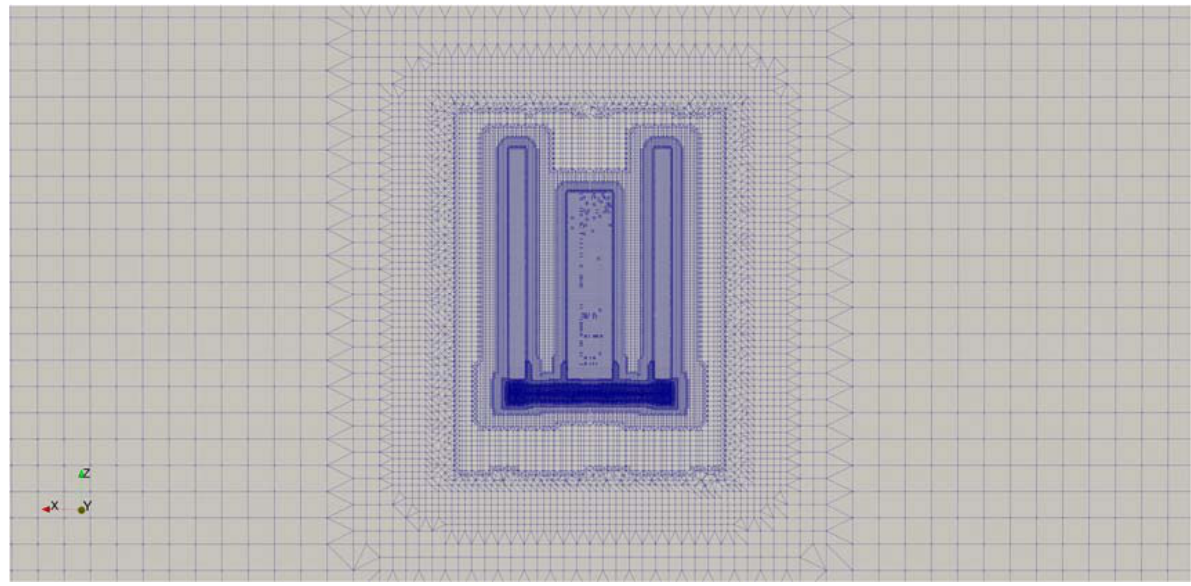
Figure 7. Full domain for the CFD simulation (view: cut in half).